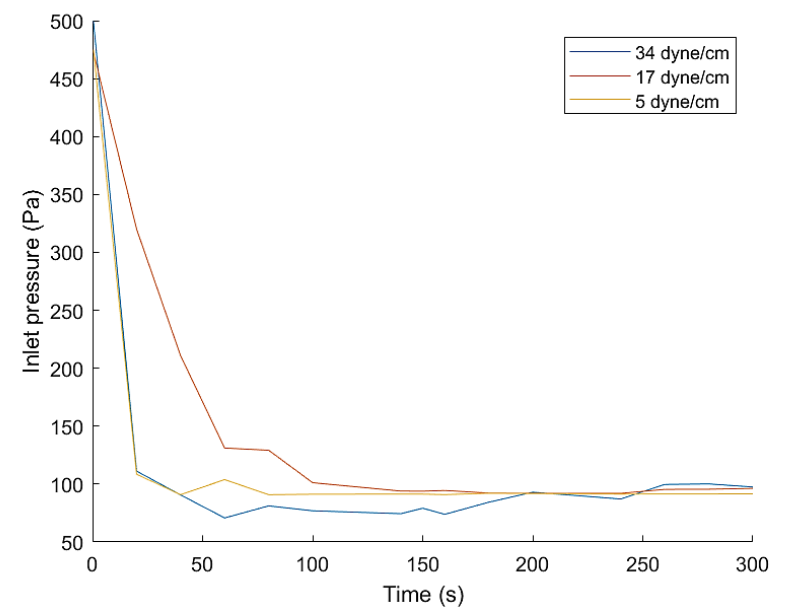
Figure 8. Inlet pressure of injected APG against time.